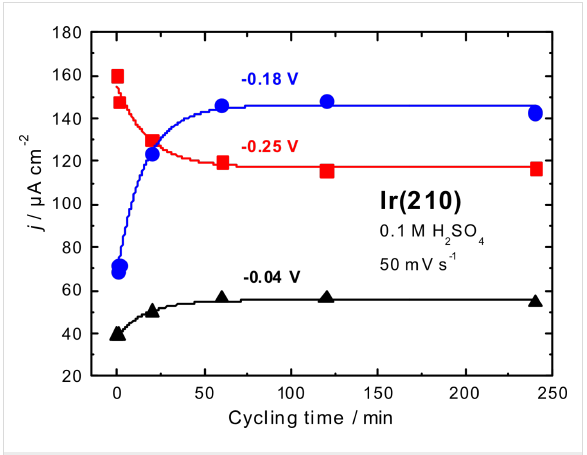
Figure 5: Current densities for hydrogen adsorption peaks of Ir(210) in 0.1 M H 2 SO 4 as a function of the potential cyclic time. The curves show non-linear fits according to first order